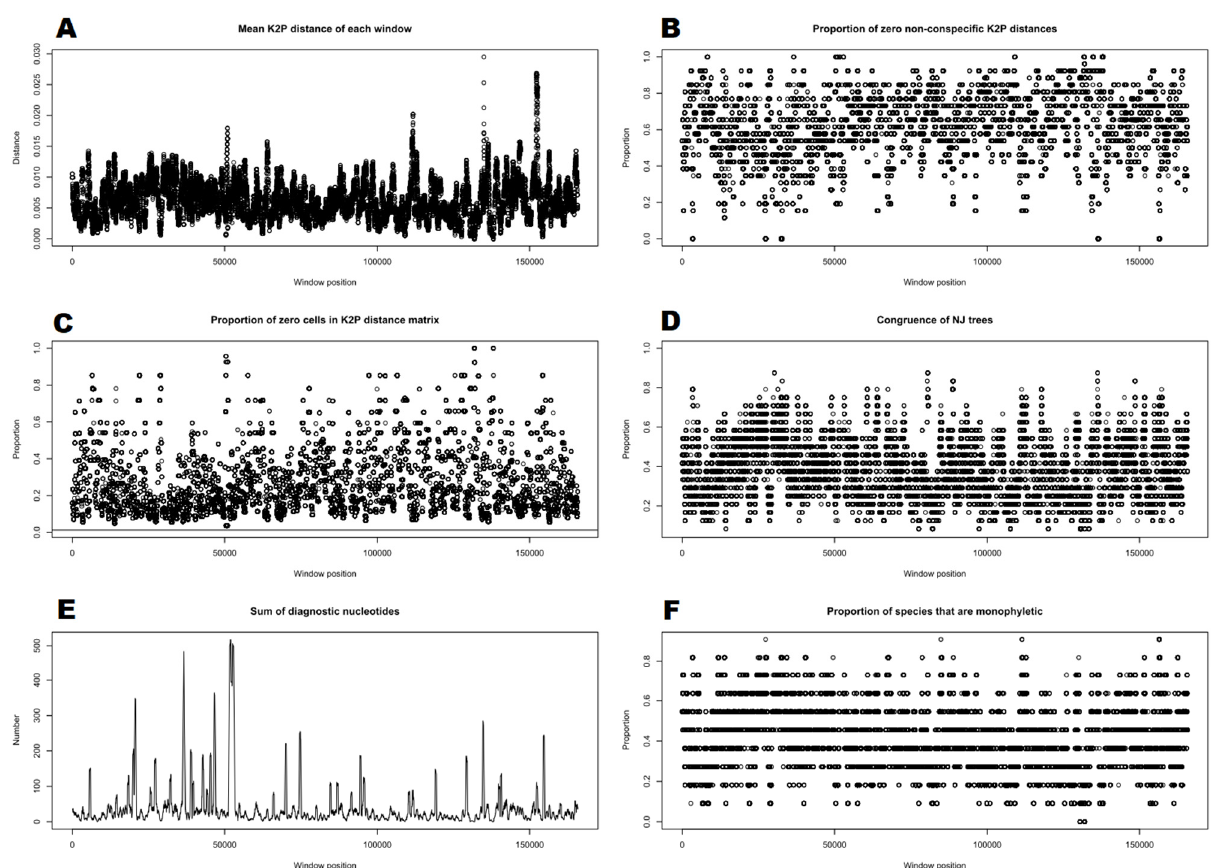
Figure 5. Results of several analyses across the mitochondrial sequences of Calypogeia sp. using the sliding-window method. ( A ) The plot of the mean Kimura 2-parameter distance matrix for each 500 bp-long window. ( B ) The proportion of zero non-conspecific distances. ( C ) The proportion of zero cells in the distance matrix. The unbroken horizontal line crossing the y -axis at 0 is the proportion of zero cells in the distance matrix created from the full dataset. ( D ) The proportion of clades that are identical between the windows and the full dataset. ( E ) The sum of diagnostic nucleotide positions for all species. ( F ) The proportion of species that are monophyletic.